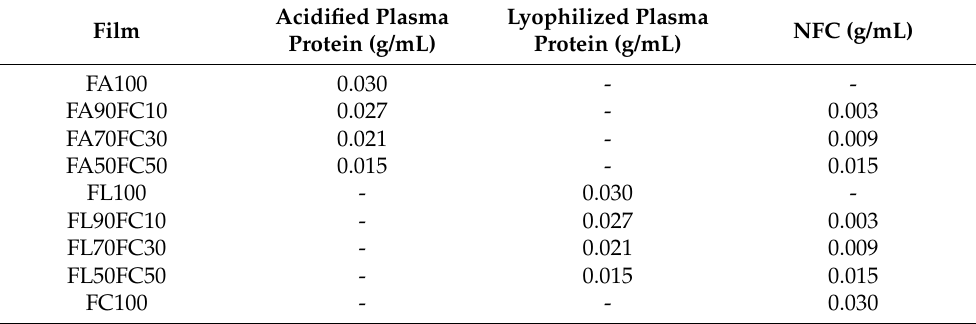
Table 1. Composition of the film-forming solutions prepared using acidified plasma